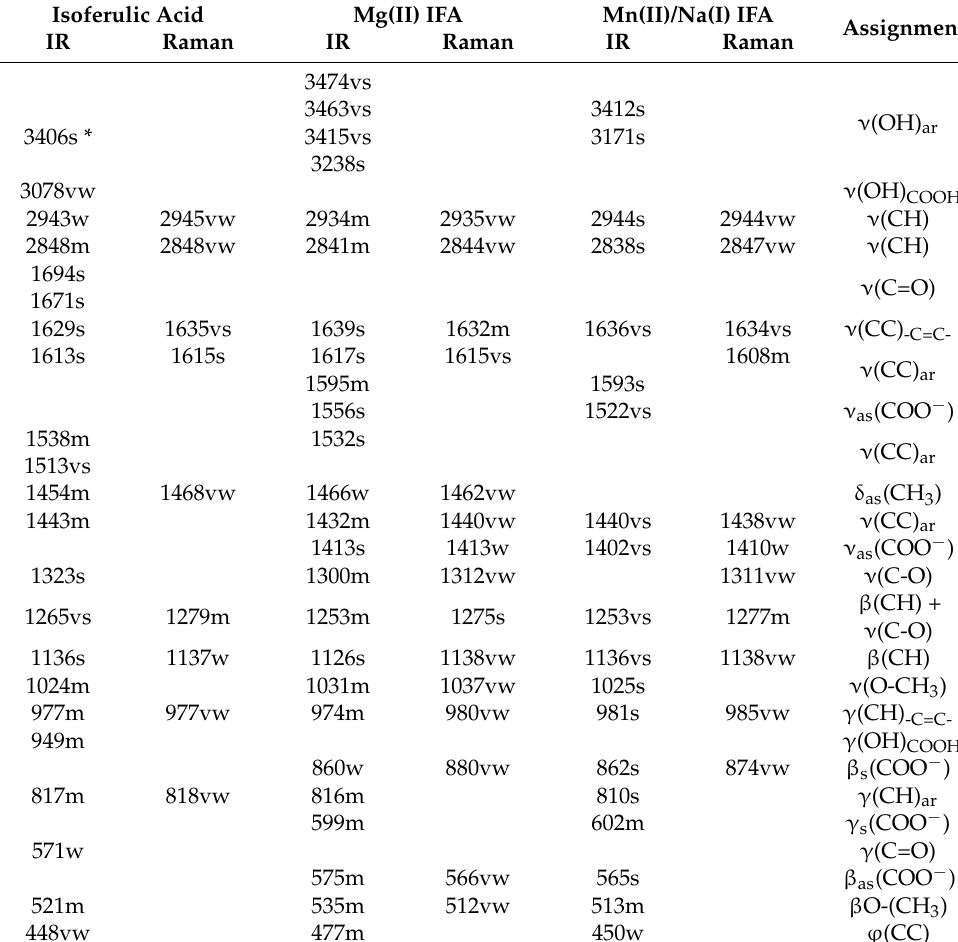
Table 3. Wavenumbers (cm − 1 ), intensities, and assignments of the selected bands occurring in the IR and Raman spectra of isoferulic acid, Mg(II) IFA, and Mn(II)/Na(I) IFA.